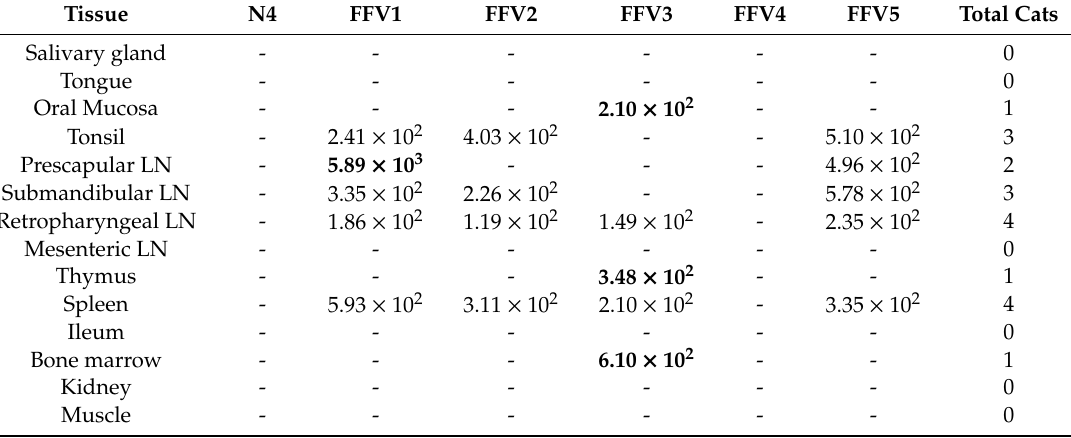
Table 3. FFV provirus has a primarily lymphoid tissue tropism. Viral load was determined through DNA qPCR and is presented as viral copies per million cells. Cat FFV3 had altered PBMC FFV DNA kinetics and expanded tissue tropism compared to the other FFV cats. Cat FFV5 was on a di ff erent inoculation schedule than the rest of the FFV cats (Materials and Methods Section 2.2 and Figure 1). Bold text indicates di ff erence in either proviral load or viral detection compared to other cats in the